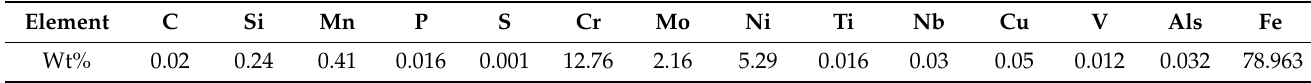
Table 1. Chemical Composition Test Results of Super 13Cr Tubing (wt%, PREN = 19.89) of Well X.